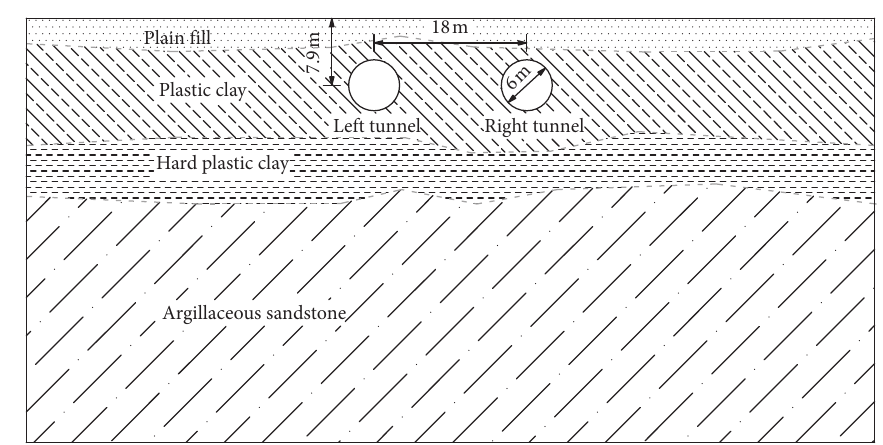
Figure 2: Elevation view of the soil